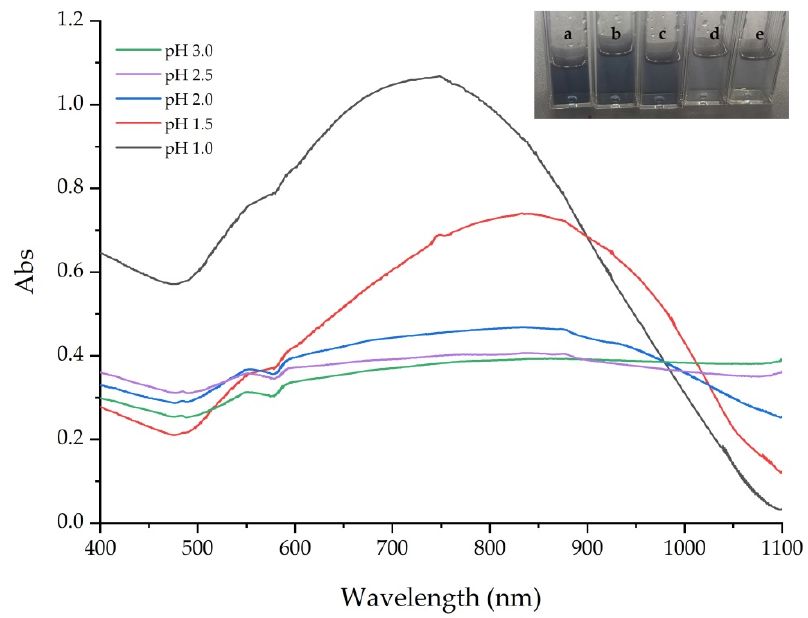
Figure 3. Absorption spectra of GNS prepared in different pH: ( a ) 1.0, ( b ) 1.5, ( c ) 2.0, ( d ) 2.5 and ( e ) 3.0.